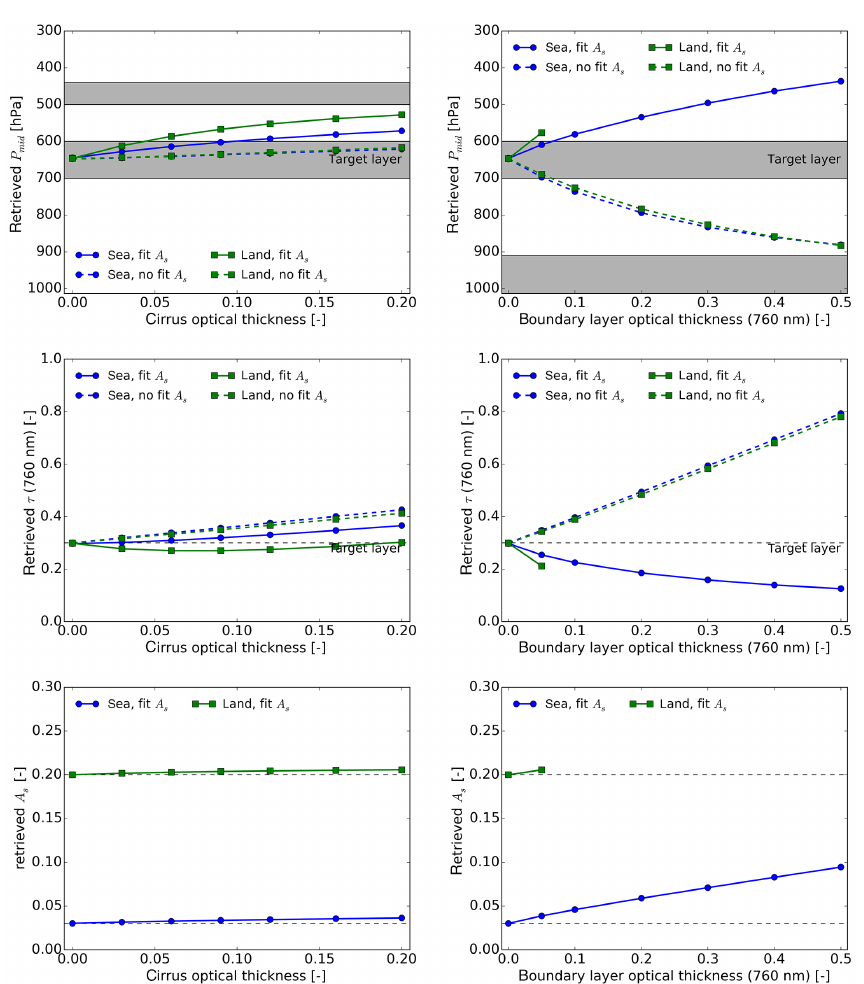
Figure 15. Results of retrieval simulations showing retrieved mid pressure (top row) of an assumed single aerosol layer with fixed pressure thickness, the layer’s retrieved optical thickness (middle row) and the retrieved surface albedo (bottom row) when in the forward simulation two scattering layers are present. Retrieved parameter values are shown as a function of the optical thickness of the interfering layer. The four plot lines correspond to sea (blue, circles) and land (green, squares) and to not fitting (dashed lines) and fitting (solid lines) the surface albedo. The target layer has an optical thickness of 0.3. Aerosols have a single scattering albedo of 1.0 and a Henyey–Greenstein phase function with asymmetry parameter of 0.7. The interfering layer is a cirrus layer (left column) or a boundary layer containing aerosols (right column). The cirrus layer has a cloud fraction of 1.0, and cirrus particles have a single scattering albedo of 1.0 and a Henyey–Greenstein phase function with asymmetry parameter of 0.8. Missing data points indicate non-converging retrievals. The solar zenith angle is 50 ◦ and the viewing direction is nadir. All other settings are the same as in the simulation study of Sect. 2 (see also Figs. 1 and